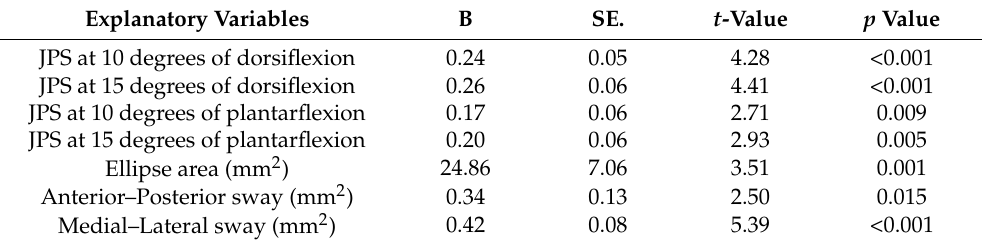
Table 3. General linear regression of TSK and explanatory variables ( n =